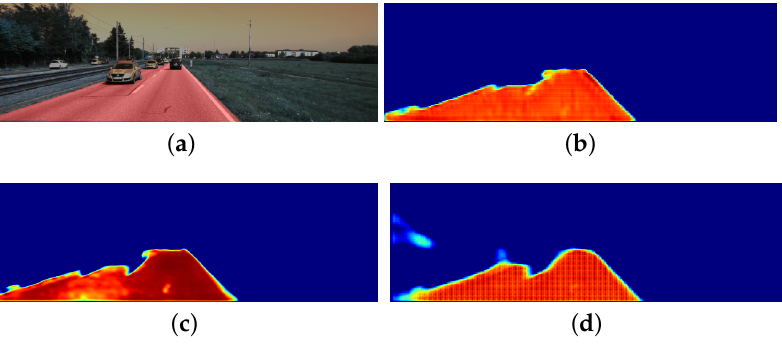
Figure 6. ( a ) Original road image from the KITTI dataset with an overlapped semantic map. ( b ) Grad- CAM results of ResNet-18 model. ( c ) Grad-CAM results of the SegNet model. ( d ) Grad-CAM results of the ResNet-50